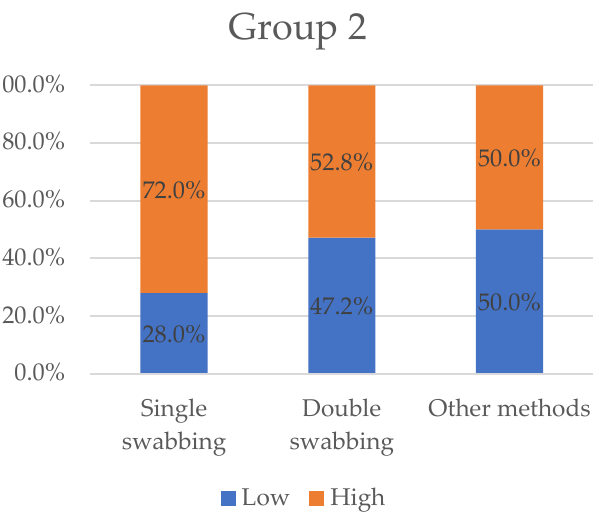
Figure 4. Variables “low” and “high” grouped by sampling methods for Group 2. Other methods collected the worst “high” value with 50%. Double-swabbing and single swabbing obtained 52.8% and 72%, respectively.